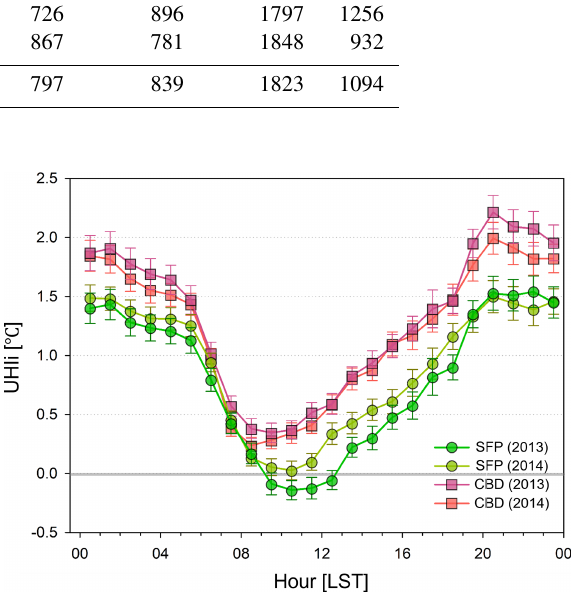
Figure 6. Hourly mean diurnal variation of the urban heat island intensity (UHIi) of the SFP and CBD in the summer of 2013 and 2014. The error bars represent standard